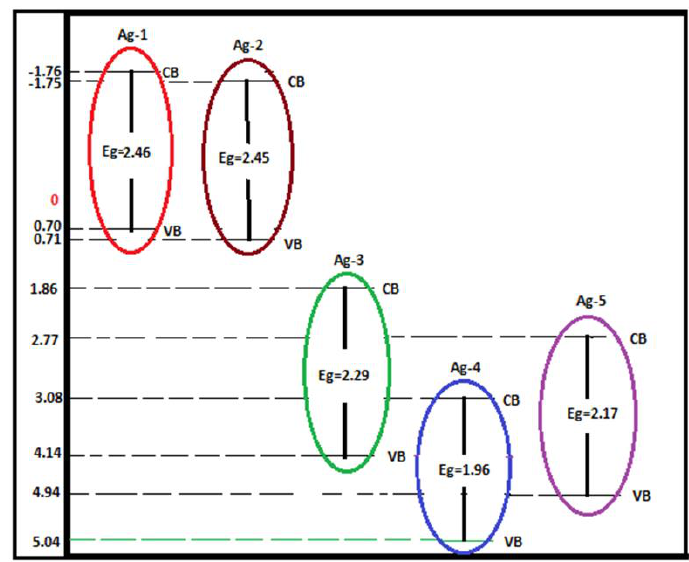
Figure 5. The Tauc plots for synthesized Ag-containing nanomaterials .